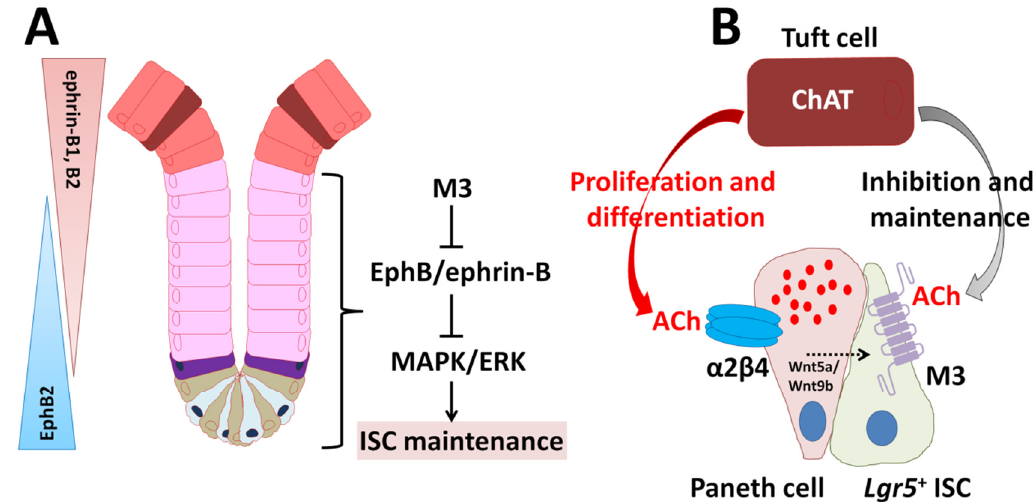
Figure 4. Model summarizing the importance of the cholinergic intestinal niche for the maintenance of IES homeostasis based on [65]. ( A ) Model depicting the proposed role of M3 through EphB/ephrin-B signaling in the ISC niche. ( B ) Non- neuronal ACh released from tuft cells activates the nicotinic receptor α 2 β 4 localized in Paneth cells and the muscarinic receptor M3 localized in ISCs. α 2 β 4 signaling modulates the expression and release of Wnt5a and Wnt9b. Eventually, proliferation and differentiation of ISCs are enhanced. The M3 signaling directly inhibits and maintains ISC proliferation and differentiation.